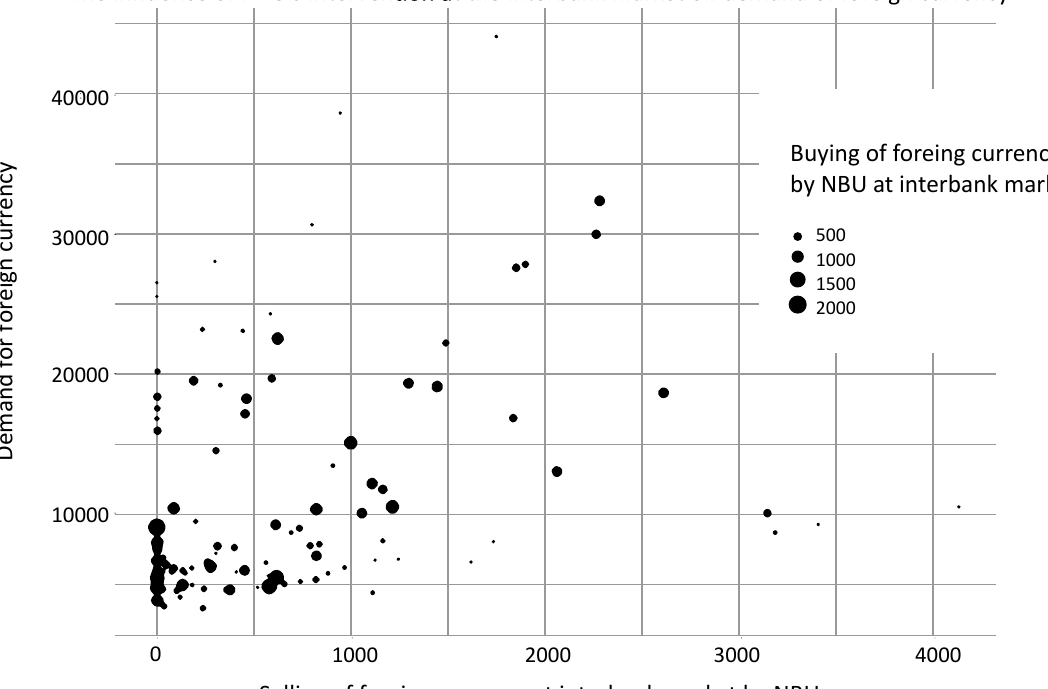
Figure 1. Influence of NBU intervention on demand of non-cash foreign currency in Ukraine, in ths